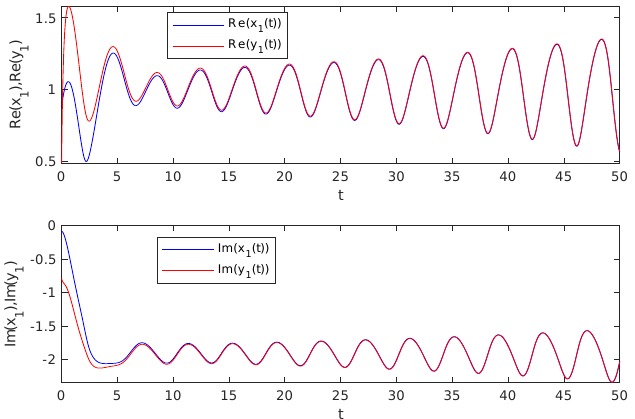
Figure 8. Synchronization evolution of x 1 ( t ) and y 1 ( t ) under the controller